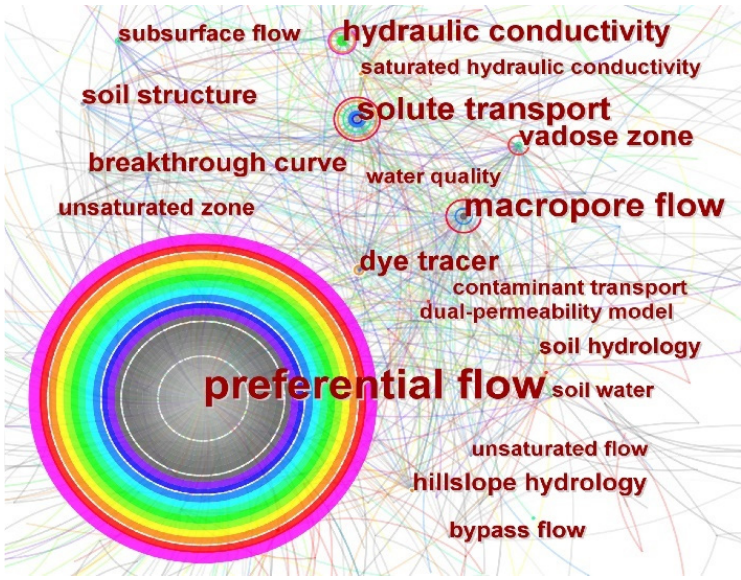
Figure 3. Knowledge map of keywords from WoS core collection database.